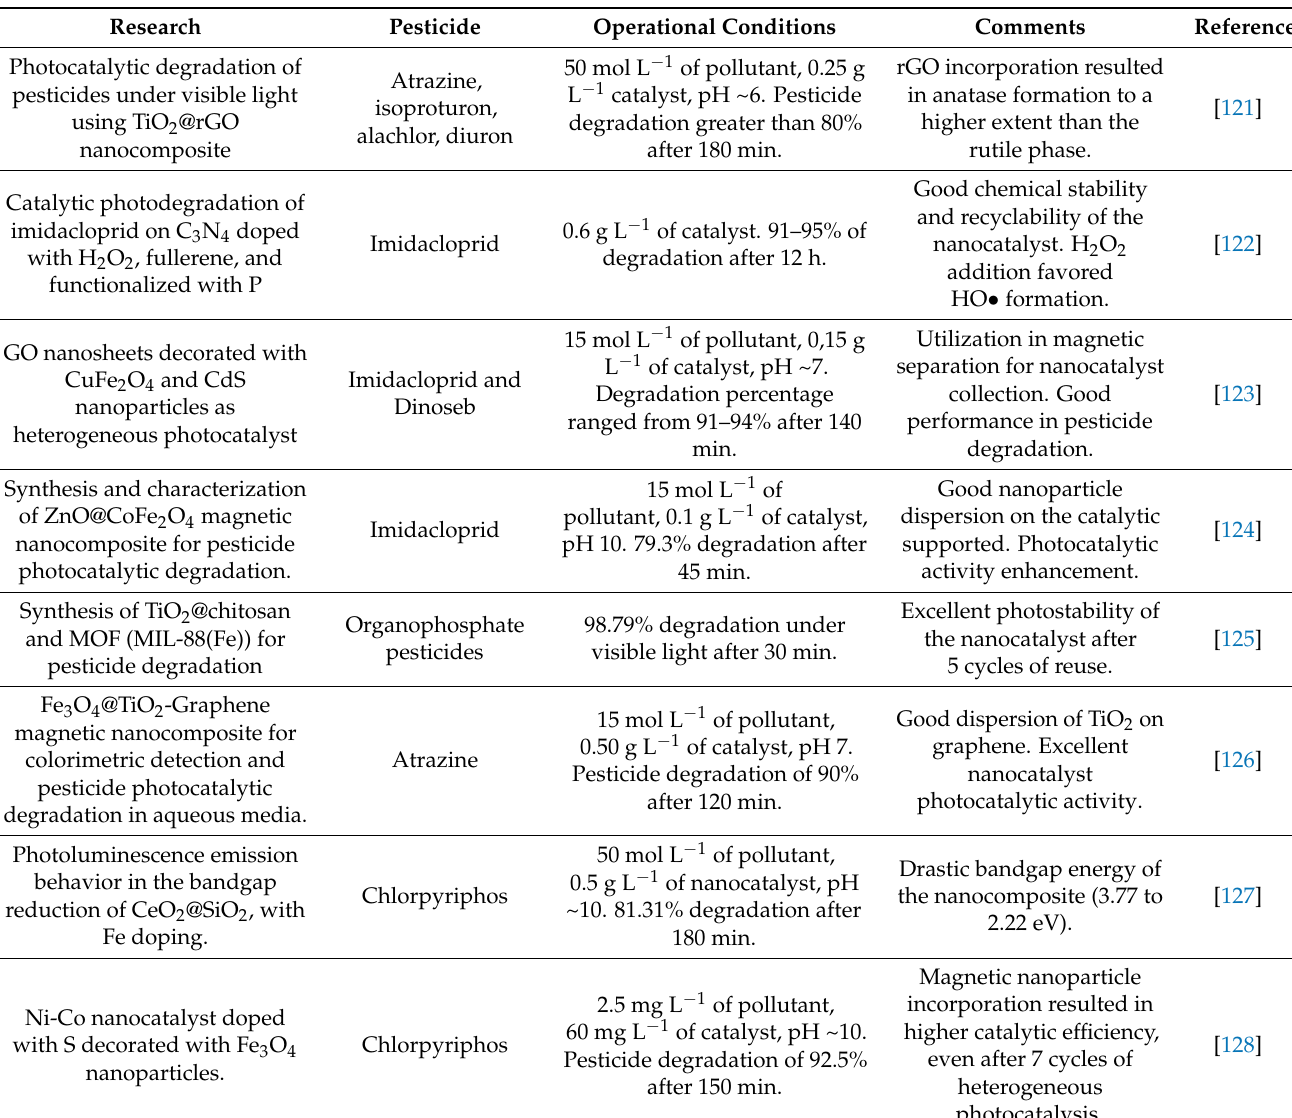
Table 2. Photocatalytic degradation of pesticides using supported nanocatalysts.